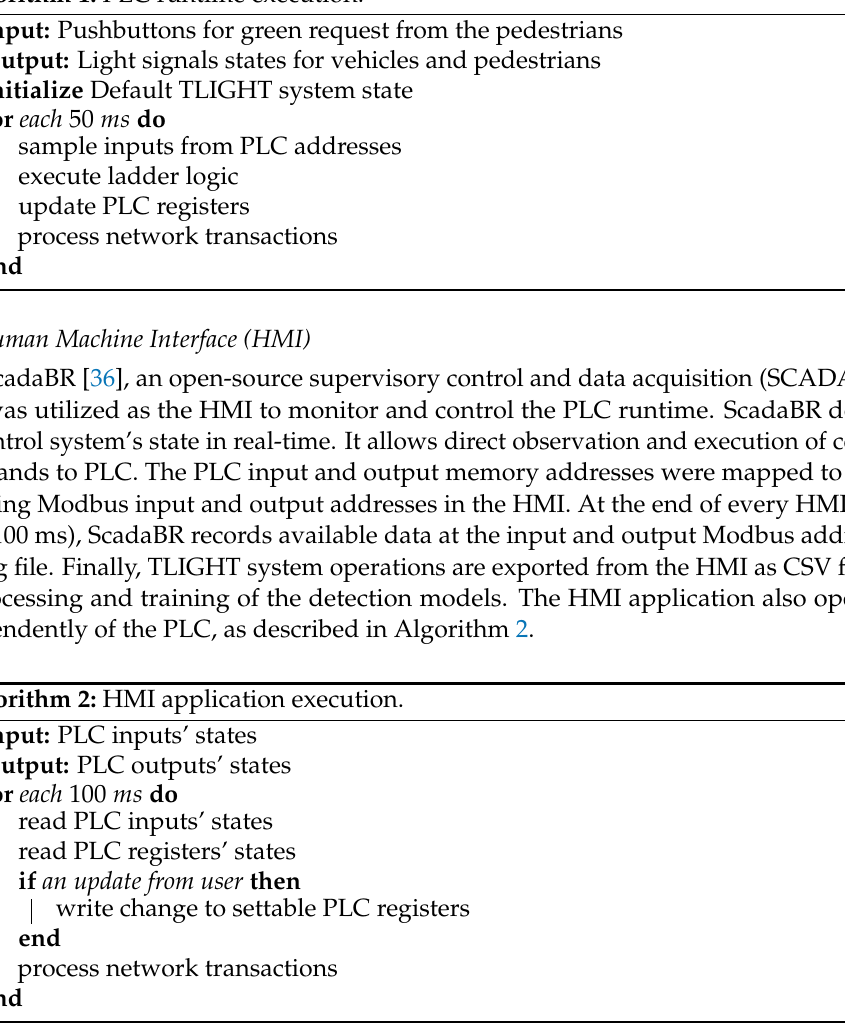
Algorithm 1: PLC runtime execution.